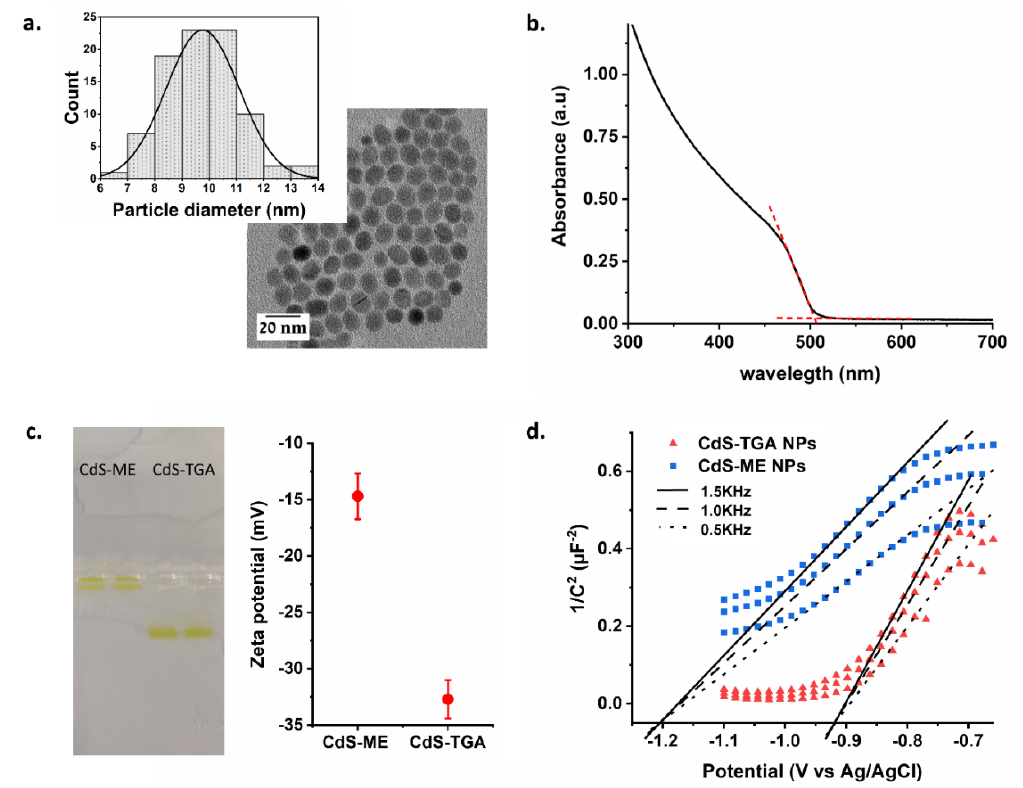
Figure 2. ( a ) TEM images of 10 nm CdS–ME NPs. Inst. CdS NPs size distribution, ( b ) UV-Vis absorbance of the 10 nm CdS NPs, ( c ) Agarose gel (0.6%) of CdS–ME/TGA NPs (1.4 μM) and zeta potential of CdS–ME/TGA NPs (120 nM) in 0.1 M PB and 51 mM AA at pH 7.2, ( d ) Mott–Schottky plots of CdS–ME/TGA NPs in 0.2 M K 2 SO 4 aqueous solution (pH = 7.2). NPs were deposited on glassy carbon electrode.